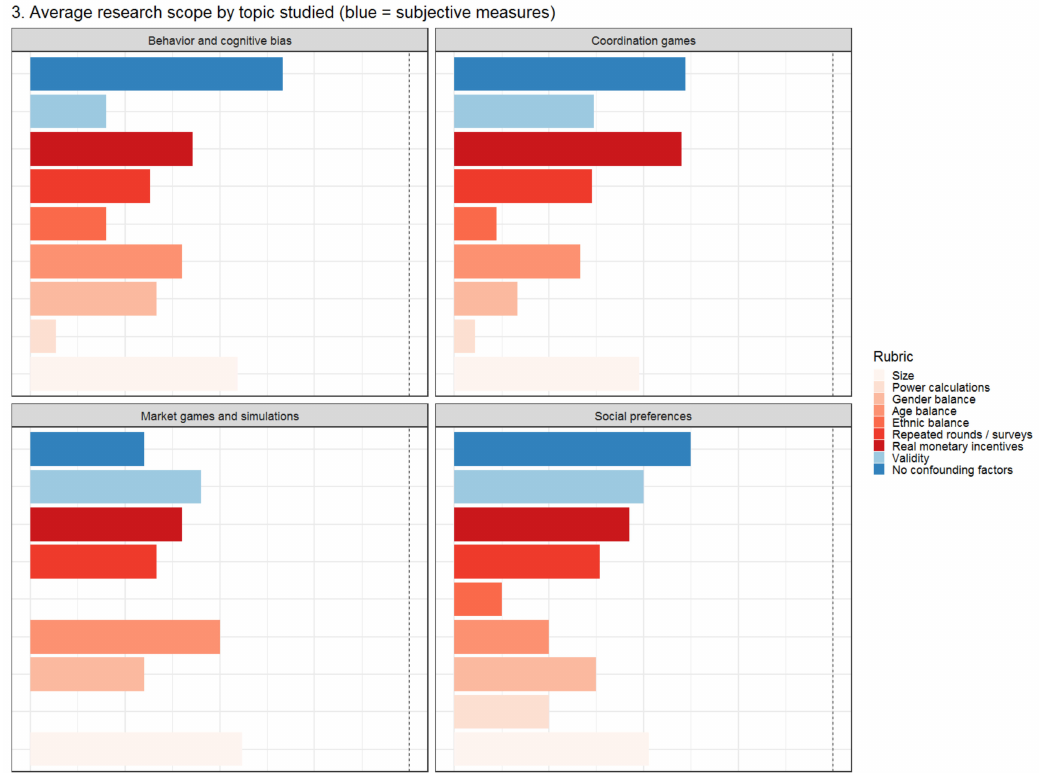
Figure 3. Average research scope by topic. Blue represents measures that required reviewers’ judgment. Variables representing aspects of research quality were transformed into a 0–1 scale for comparability (see Appendix A, Table A2 for the coding